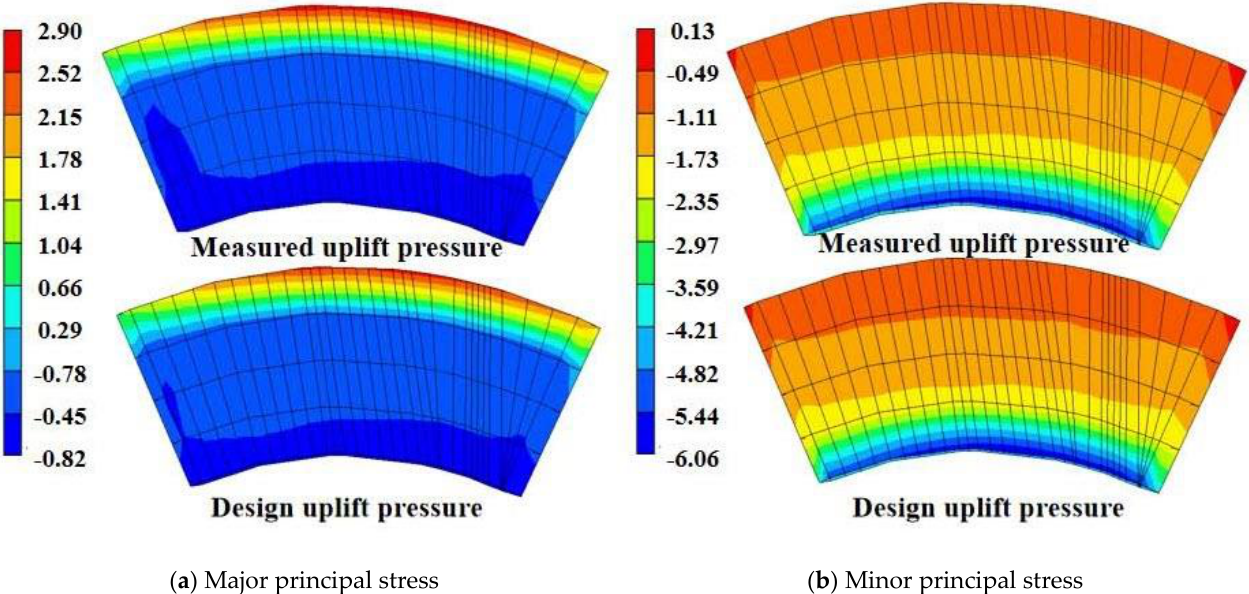
Figure 13. Contour map of foundation stress in the riverbed under measured uplift pressure (Unit: MPa).